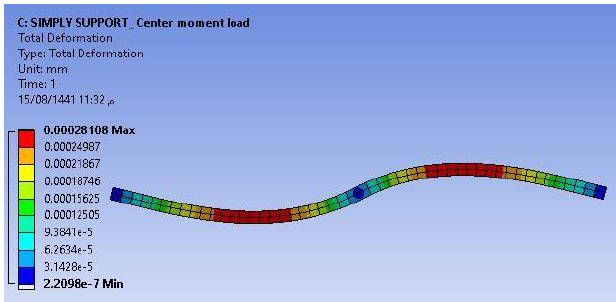
Fig. 12. Total deformation (0.00028 Max) of cemented carbide, simply supported centre moment of 100 N.mm